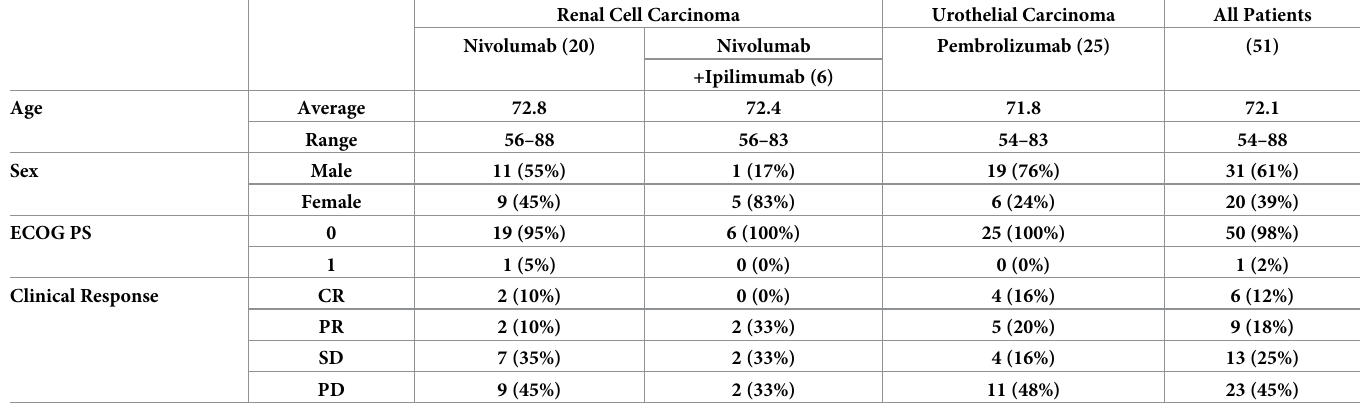
Table 2 summarizes the characteristics of the patients receiving ICI therapy. Fifty-one patients with metastatic renal or urothelial carcinoma were enrolled. Their mean age was 72.1 years (range: 54–88 years). The male-to-female ratio was 32: 19. Of the total, 26 (51%) patients had renal carcinoma, and 25 (49%) had urothelial carcinoma (bladder carcinoma: 13; upper uri- nary carcinoma: 12). The median follow-up time was 2.6 (range: 0.4–40.7) months. Table 2. Patient